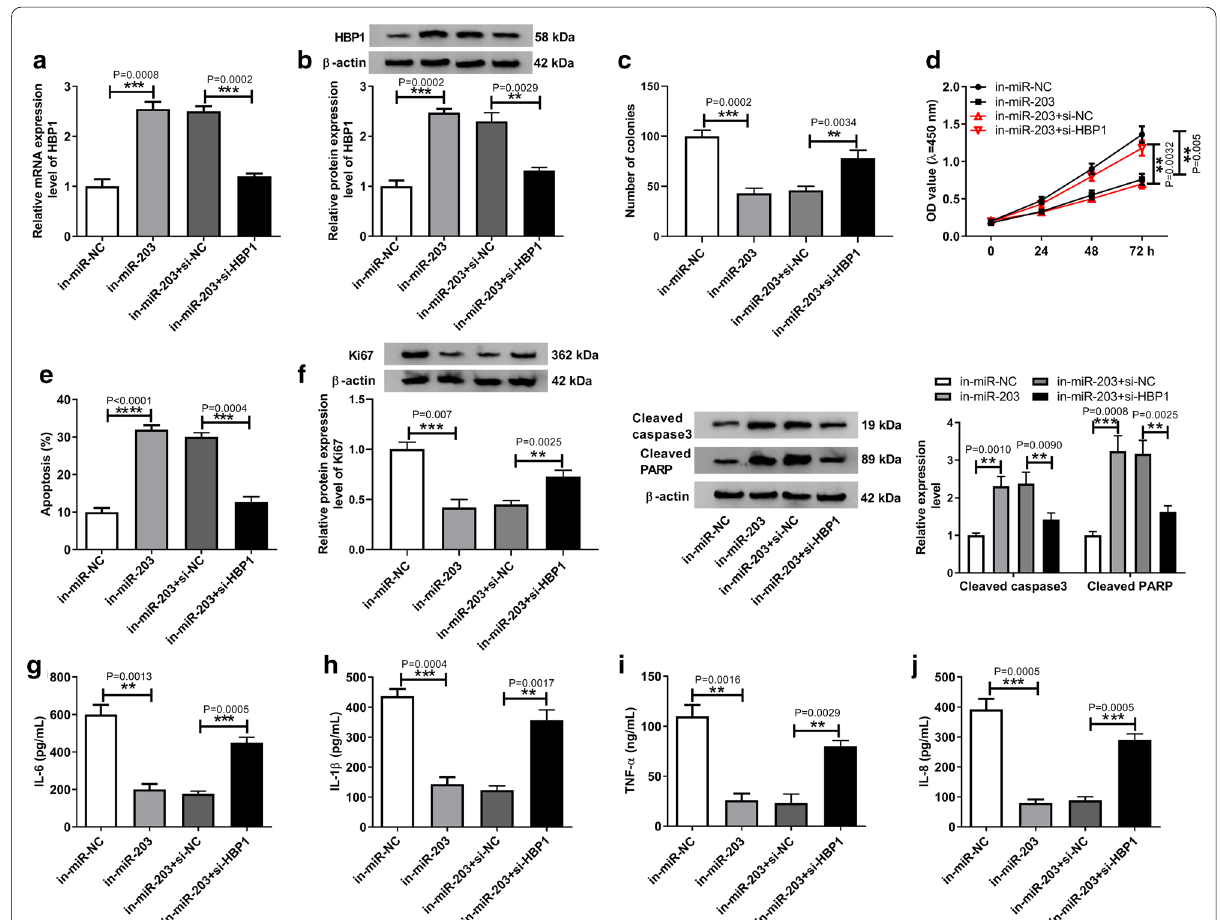
Fig. 6 HBP1 silence reverses the function of miR-203 on RASF growth and inflammation. RASFs were transfected with in-miR-NC, in-miR-203, in-miR-203 si-NC, or in-miR-203 si-HBP1. a , b Transfection efficiency was analyzed by using qRT-PCR or western blot. c , d The proliferation of + + RASFs was determined by colony formation assay and CCK-8 assay, respectively. e Flow cytometry was applied to detect the apoptosis of RASFs. f Western bolt analysis of Ki67, cleaved caspase3 and cleaved PARP expression in RASFs was carried out. g – j The level of inflammatory cytokines IL-6, IL-1β, IL-8 and TNF-α in RASFs was detected by ELISA assay. * p < 0.05, ** p < 0.01, *** p < 0.001, **** p < 0.0001